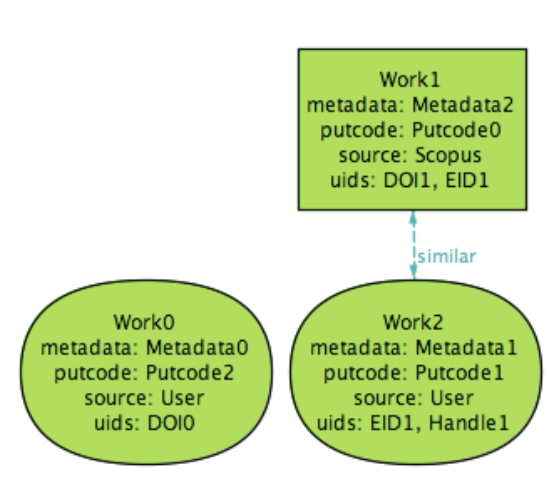
Figure 5. Initial ORCID profile.